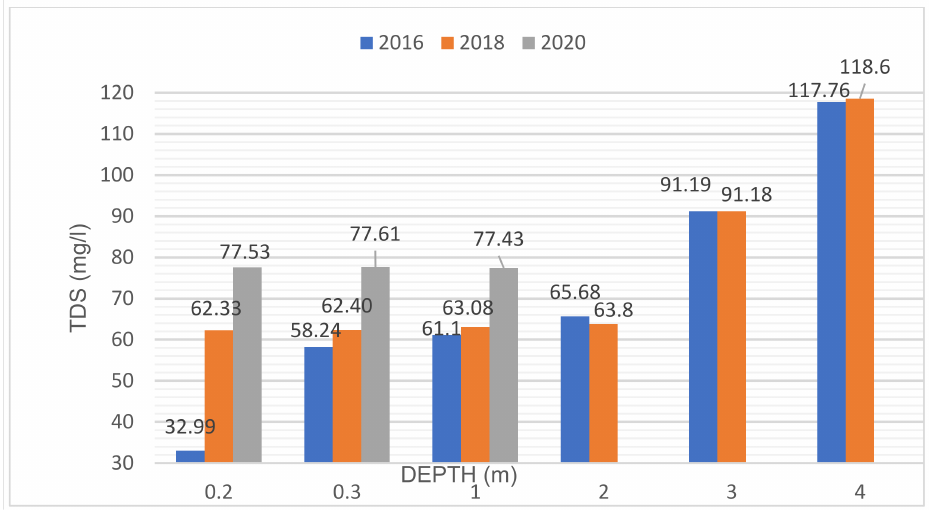
Figure 6. TDS values at several depths of Lake